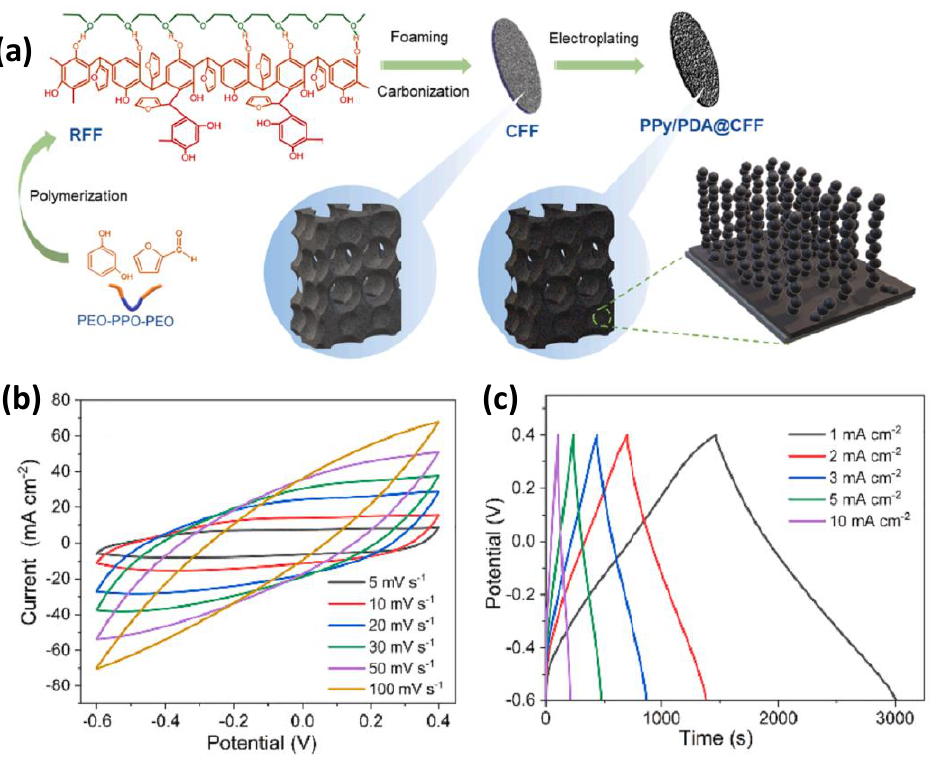
Figure 10. ( a ) Diagram of the preparation process of PPy/PDA@CFFs. ( b ) CV curves of PPy/PDA@CFF-20 at different scan rates. ( c ) GCD curves of PPy/PDA@CFF-20 at different current densities. Reproduced with permission [208] Copyright © 2022, Chemical Engineering Journal.